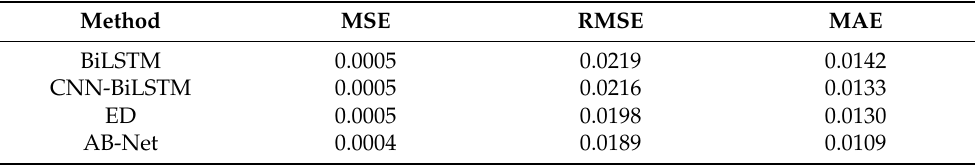
Table 3. Results obtained for different models on wind data via ablation study.